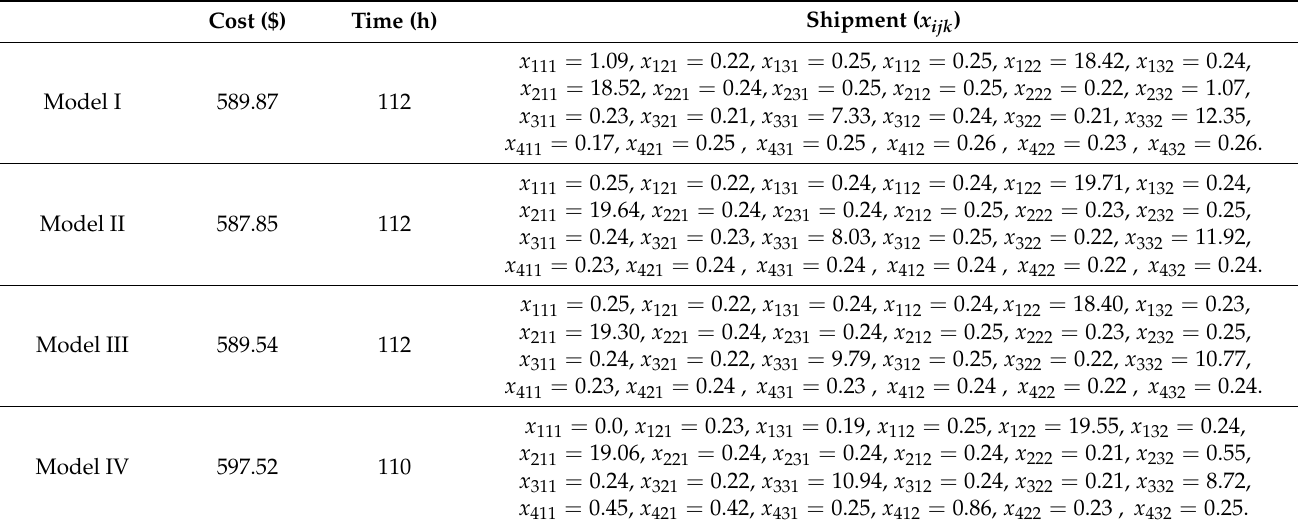
Table 4. Optimal solutions for 4 stochastic models using the GCM